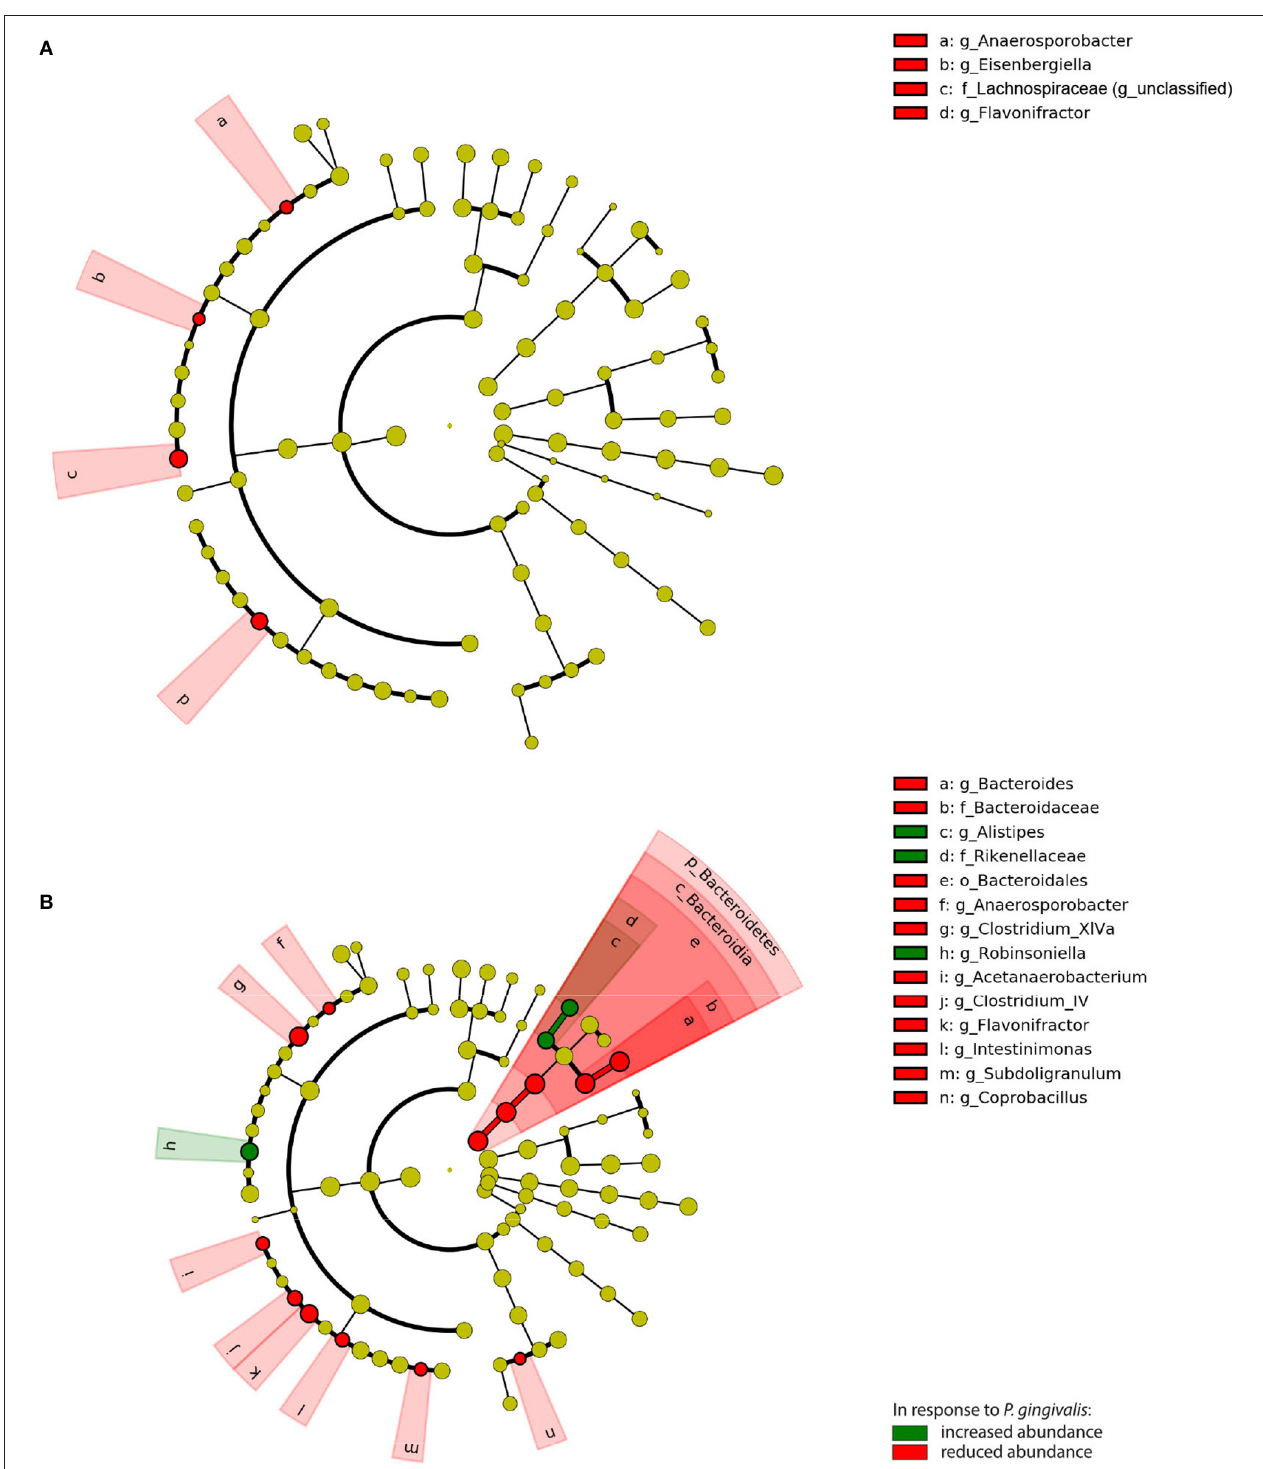
FIGURE 5 | Chronic P. gingivalis infection persistently disrupts microbiota composition in mice fed a Western diet. Linear discriminant analysis (LDA) effect size (LEfSe) analysis of predicted taxonomy from 16S rRNA gene sequencing of the cecal microbiota. (A) P. gingivalis vs. vehicle-treated mice fed a WD. (B) P. gingivalis vs. vehicle-treated mice fed a CD. LDA > 2.0, α < 0.05. For all comparisons, green indicates increased abundance while red indicates reduced abundance in response to P. gingivalis .